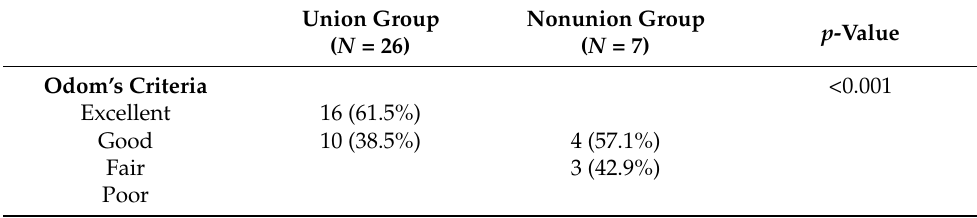
Table 2. Clinical outcomes using Odom’s criteria in conservatively managed anterior tear drop fractures of C2.